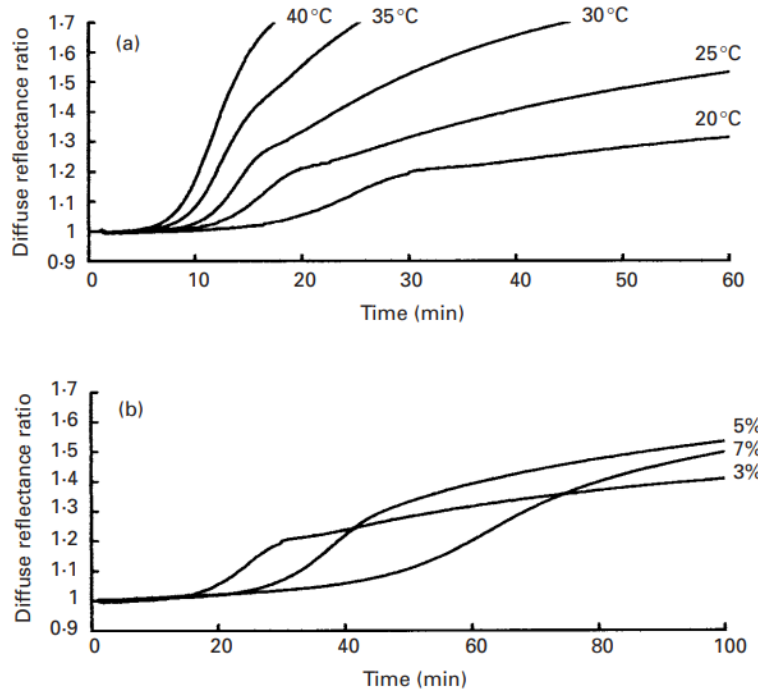
Figure 10. Effect of temperature and protein concentration on apparition of a shoulder in the curve of diffuse reflectance ratio versus time. ( a ) Data corresponded to skim milk adjusted to 30 g protein/kg and coagulated at 20, 25, 30, 35, and 40 ◦ C and at constant calcium chloride and enzyme concentration. ( b ) Data corresponded to skim milk adjusted to 30, 50, and 70 g protein/kg and coagulated at 20 ◦ C and at constant calcium chloride and enzyme concentration. Reproduced with permission from [Castillo, M.Z.; Payne, F.A.; Hicks, C.L.; Laencina, J.S.; López, M.-B.M.], [Modelling Casein Aggregation and Curd Firming in Goats’ Milk from Backscatter of Infrared Light.]; published by [ J. Dairy Res. ],